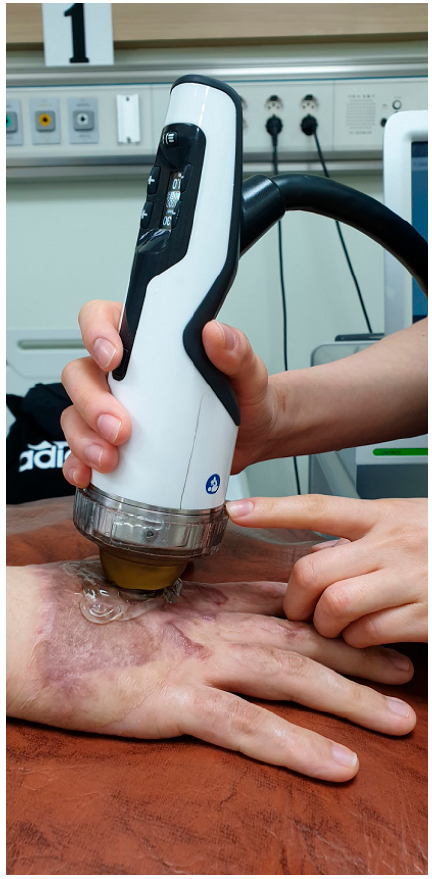
Figure 2. The extracorporeal shock wave therapy was administered to burn patients. The administered shock wave dose was 100 impulses/cm 2 at 0.05 to 0.30mJ/mm 2 with a total of 1000 to 2000 impulses per treatment.